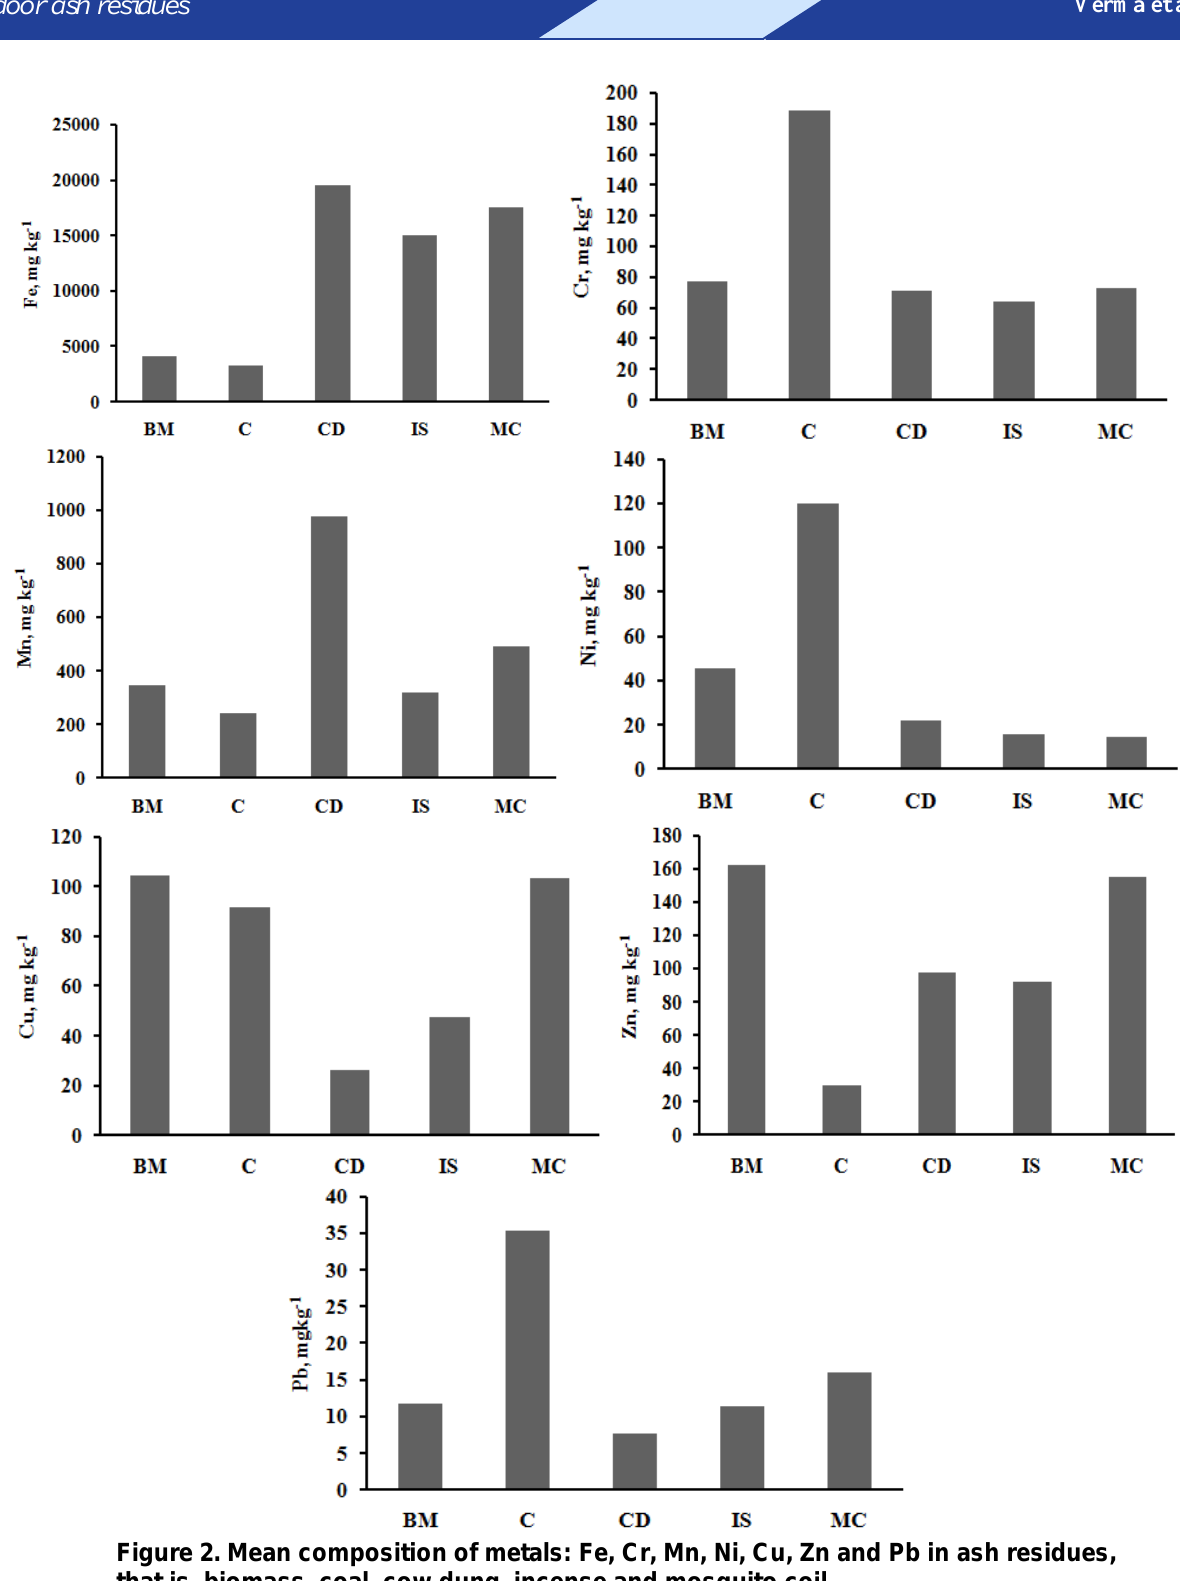
Figure 2. Mean composition of metals: Fe, Cr, Mn, Ni, Cu, Zn and Pb in ash residues, that is, biomass, coal, cow dung, incense and mosquito coil BM: Biomass; C: Coal; CD: Cow dung; IS: Incense; MC: Mosquito